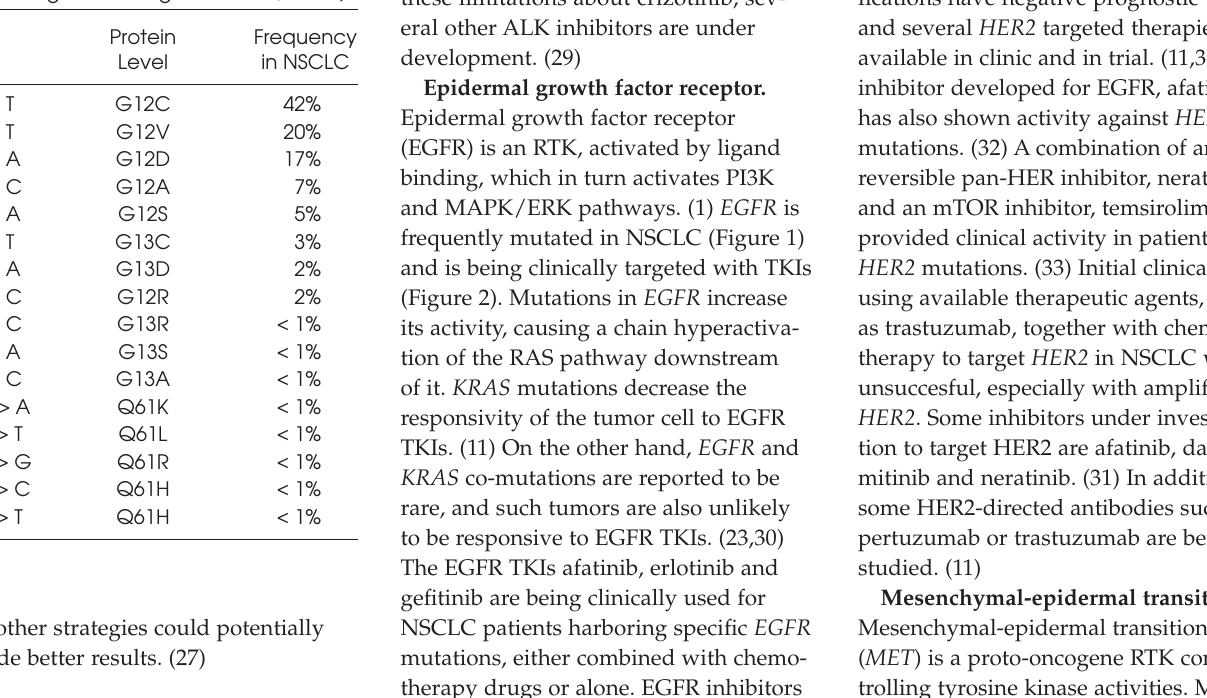
Table 1. KRAS mutations reported to date. (Data obtained from https:// mycancergenome.org on June 2,